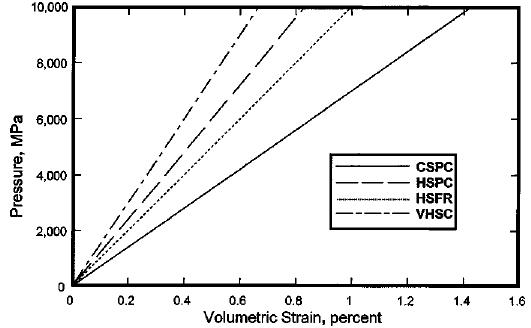
Fig. 5. Pressure-volumetric strain responses used in the spheri- cal-cavity expansion model for the CSPC, HSPC, HSFR, and VHSC concretes.